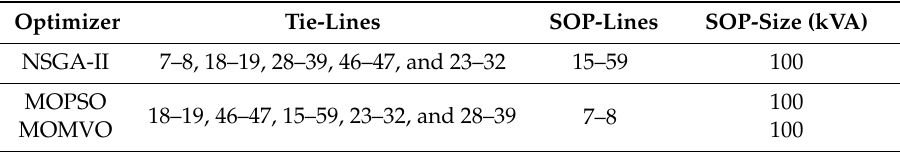
Table 3. Tie-lines, soft open points (SOPs) size, and